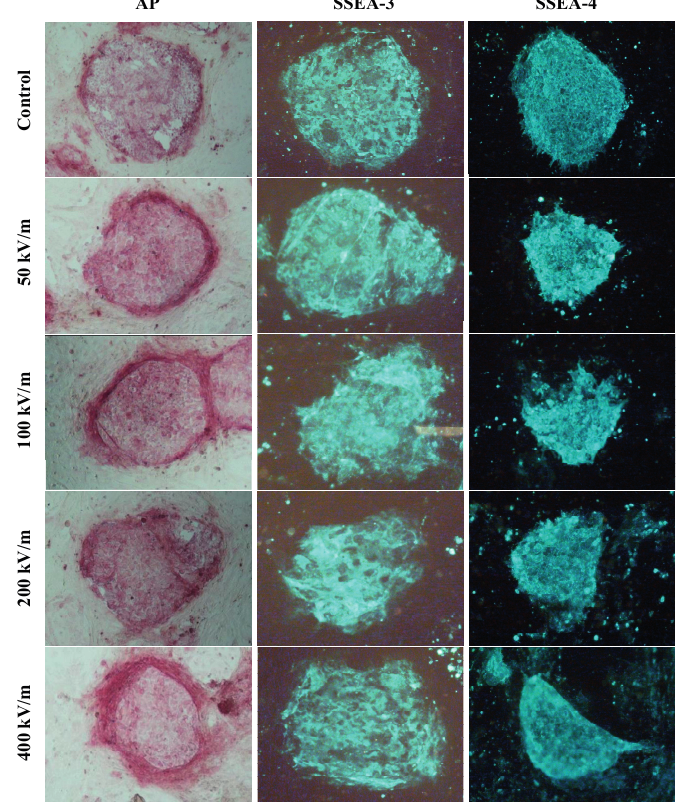
Figure 1. Expression of human embryonic stem cell (hESC) undifferentiated markers in HUES-17 cells after exposed to pulsed electromagnetic field (PEMF) at different electric field intensities. The expression of alkaline phosphatase (AP), stage-specific embryonic antigen-3 (SSEA-3) and SSEA-4 in HUES-17 cells was detected by AP staining and immunofluorescent staining after the cells were exposed to 400 pulses PEMF at electric field intensities of 50, 100, 200, 400 kV/m or sham-exposed (control group). Abbreviations: AP, alkaline phosphatase; SSEA, stage-specific embryonic antigen; PEMF, pulsed electromagnetic